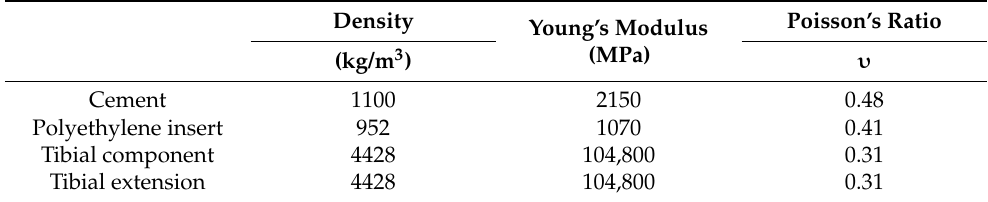
Table 2. Implant properties of virtual model.